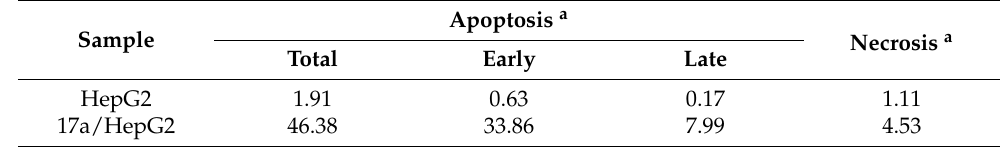
Table 4. Effect of compound 17a on apoptosis in the HepG2 cells.